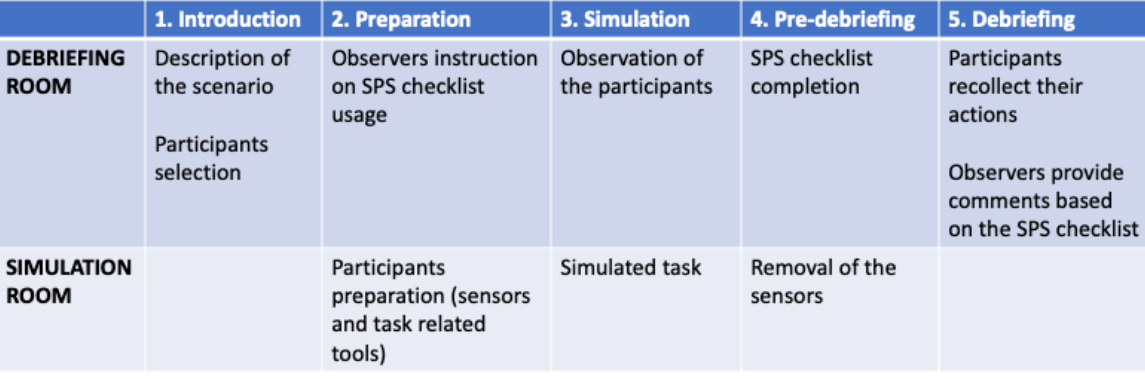
Figure 5. The phases of the procedure of the training.